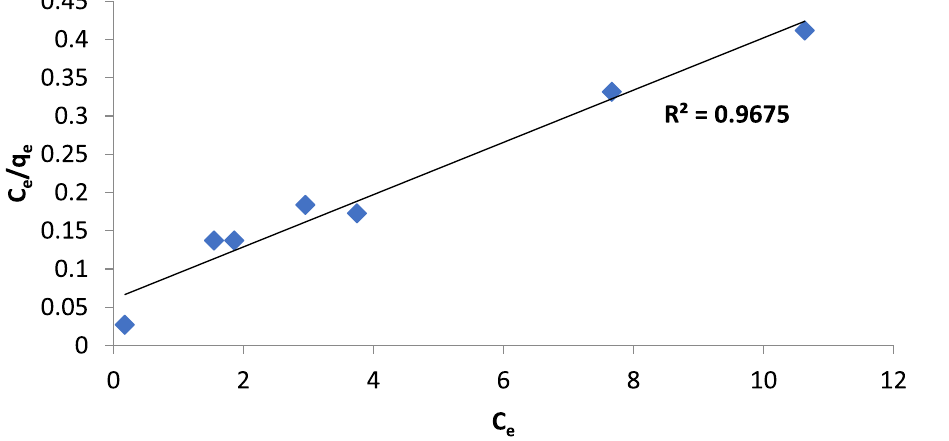
Figure 8. Langmuir isotherm of BF dye by Gel@GO-F-ZrSiO 4